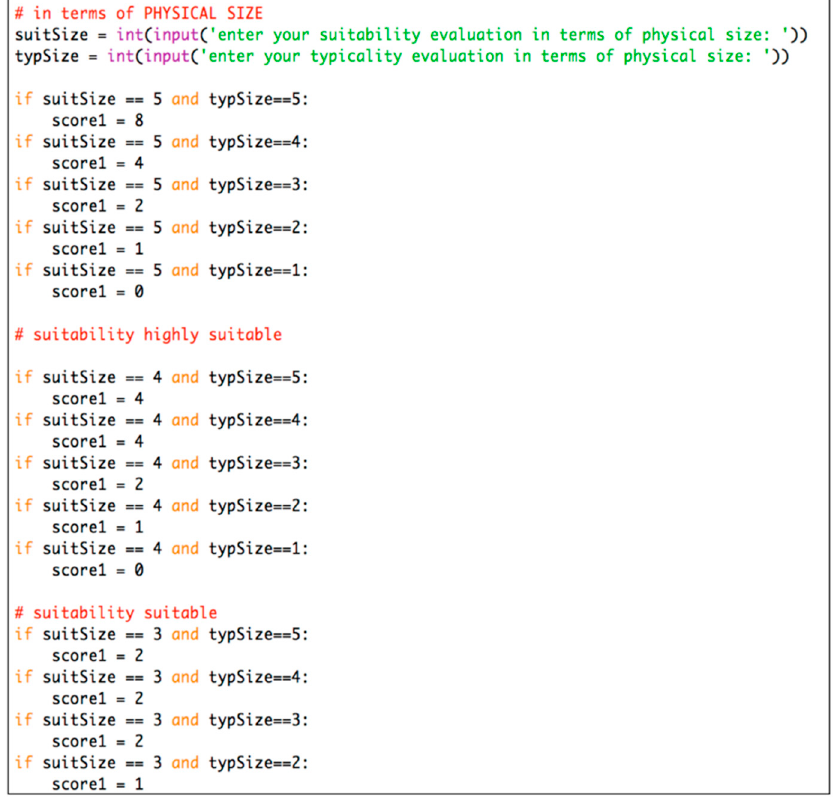
Figure 14. Python script for scoring the suitability of spatial features based on the algorithm proposed in Reference [10].